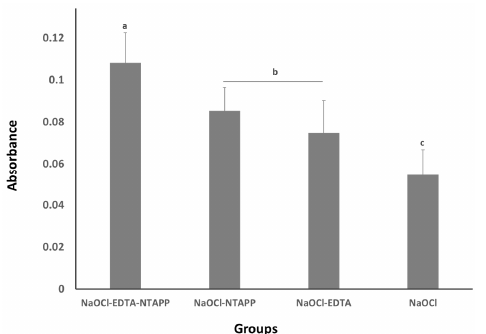
Figure 2. Human dental pulp cells viability and proliferation on dentin was measured by MTT assay. Different lowercase letters indicate statistically significant differences ( p < 0.05). 3.2. Treatments Altered Dentin Surface and hDPSCs Response Dentin surfaces appeared different between treatment groups (Figure 3). Intertubu- lar dentin appeared sleek and dentinal tubule orifices were intact on NTAPP-treated den- tin (Group I and II). Smear layers were absent on EDTA-treated dentin (Groups I and III). Irregular scaly surfaces and eroded tubule orifices appeared on dentin treated with NaOCl alone (Group IV). hDPSCs attached and spread out on all dentin surfaces (Figure 3), with differences in densities between treatments that reflected differences in viability (Figure 2). There was more attachment, spreading, longer cytoplasmic processes and higher densities from mul- tiple layers that had merged to form clusters on NTAPP-treated dentin. Instead, markedly fewer isolated cells, much less spreading and shorter processes were seen on dentin con- trols (NaOCl-only).